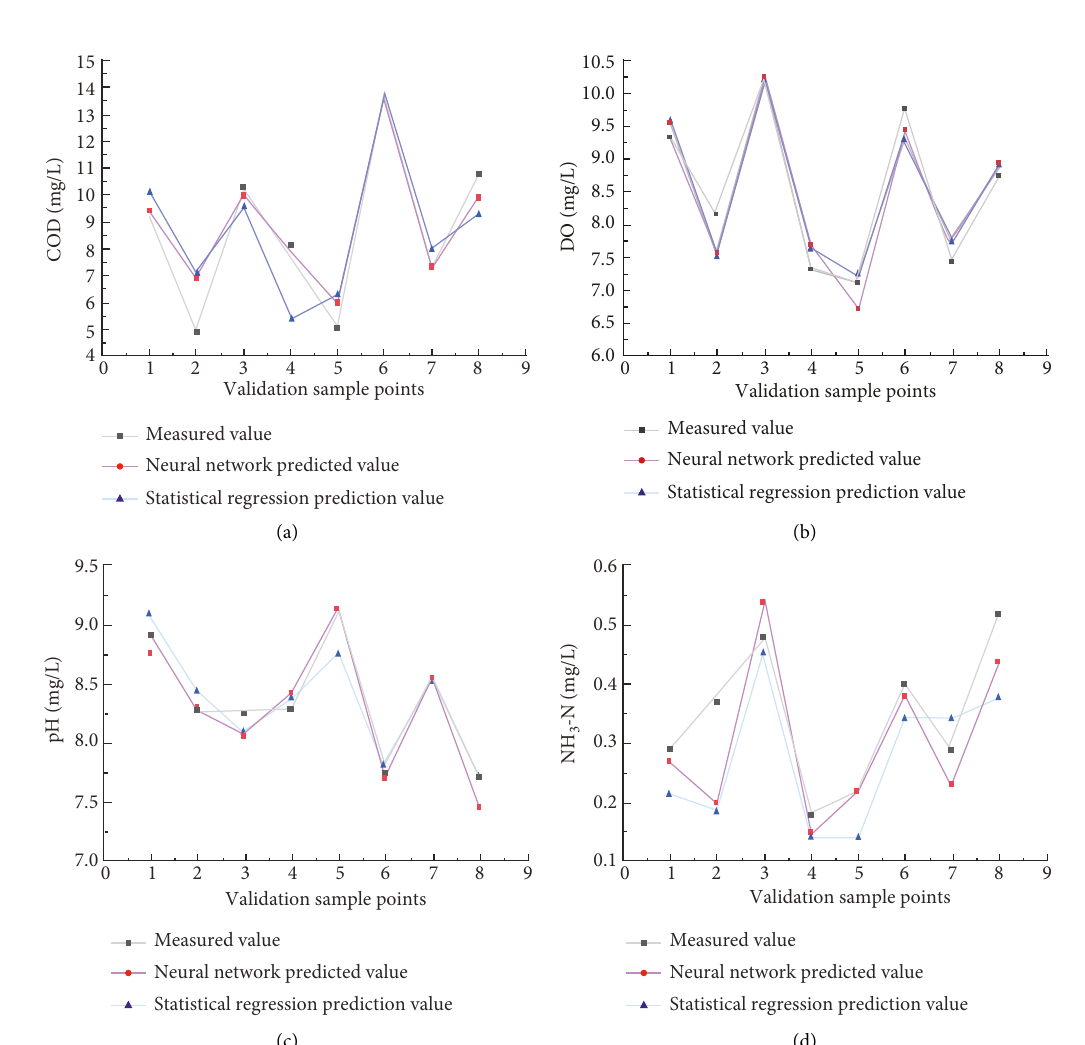
Figure 3: Comparison of measured values, neural network predicted values, and multiple regression predicted values.